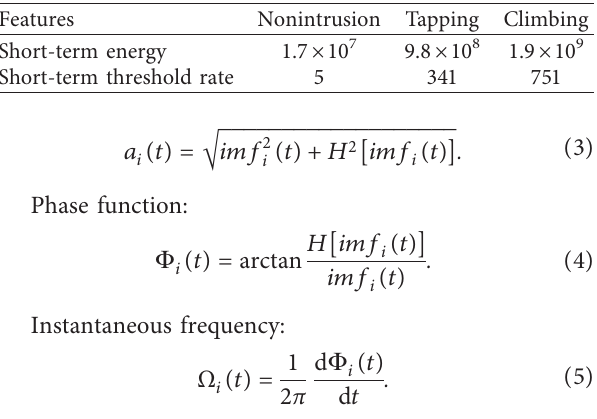
Figure 5: Comparison of the results of three denoising methods. (a) Original signal. (b) Differential filtered signal. (c) Butterworth high filtered signal. (d) Wavelet threshold denoising reconstruction signal. Table 2: Time-domain characteristics of a frame fiber vibration